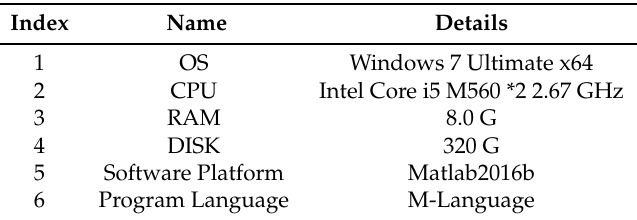
Table 3. Experimental platform configuration.